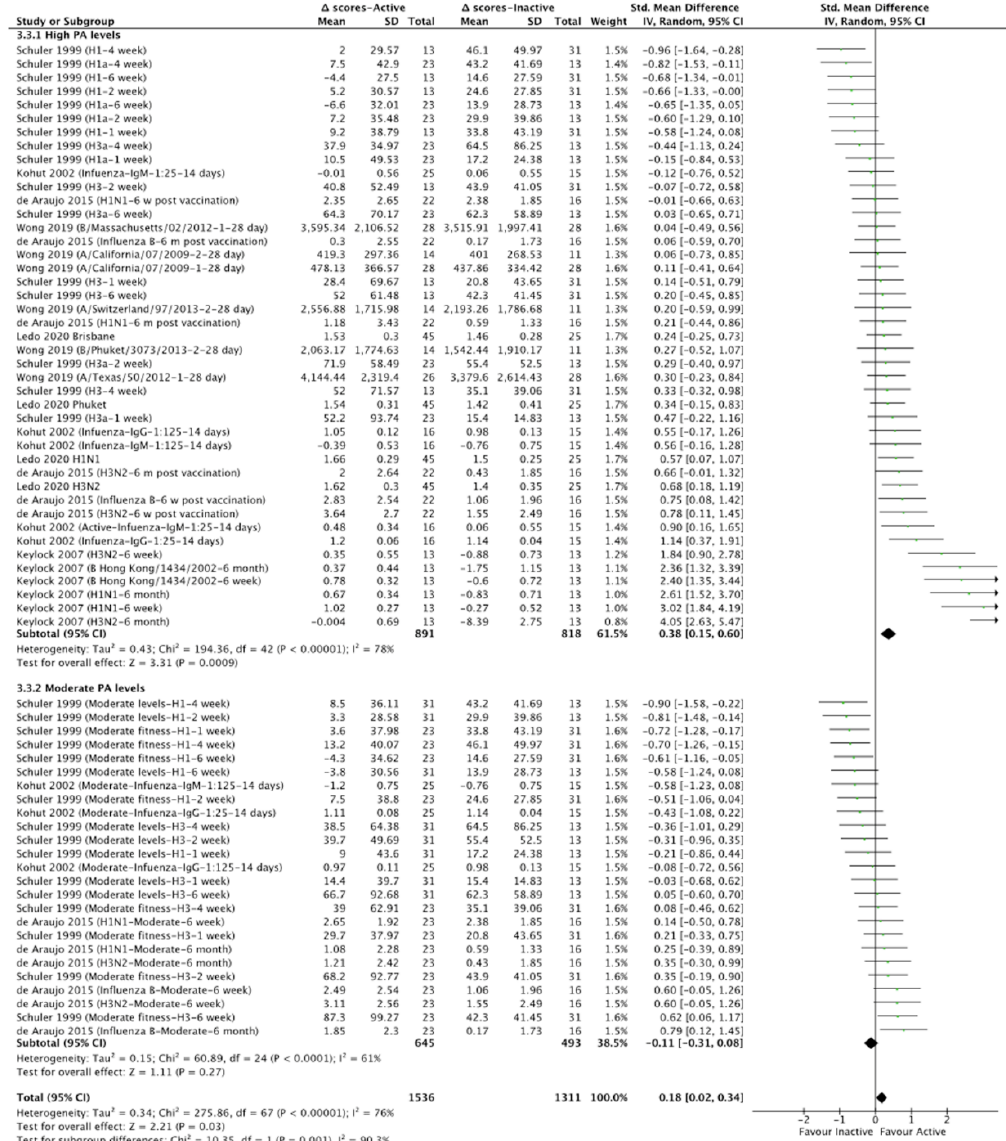
Figure 2. Forest plot of the effect of physical activity levels on influenza vaccine antibodies (subgroup analysis for high and moderate physical activity levels). Δ scores: post intervention–baseline; SD: standard deviation; 95% CI: 95% confidence interval.